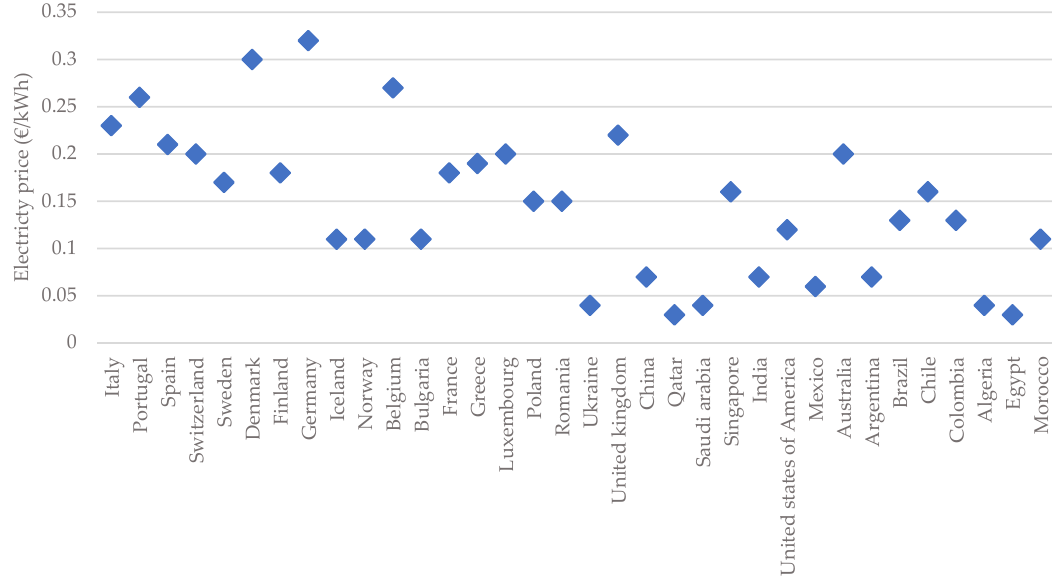
Figure 6. Considered electricity prices in all countries [37].